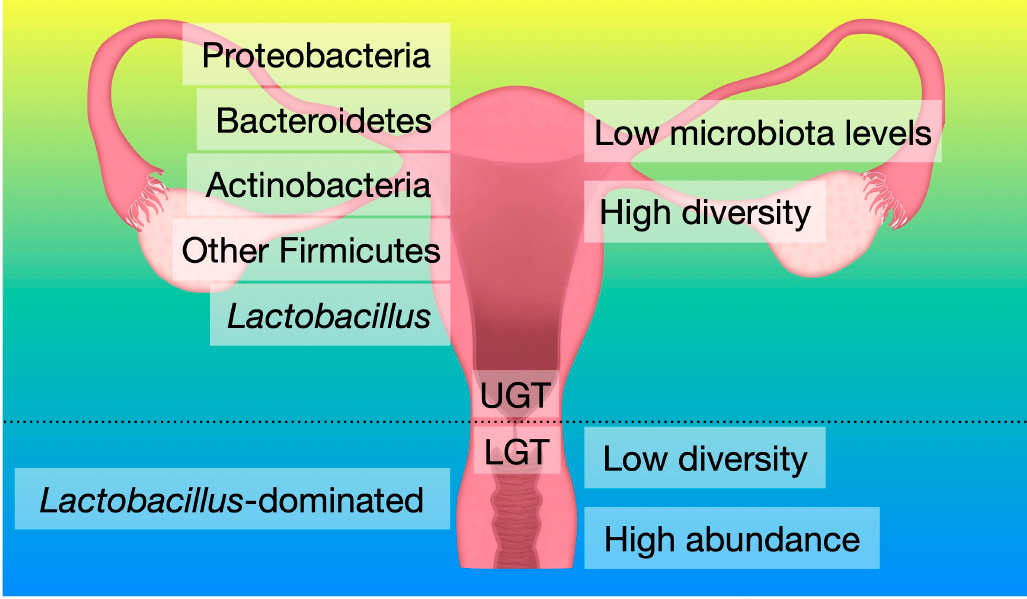
Figure 1. General characteristics of bacterial communities of the lower genital tract (LGT) and the upper genital tract (UGT).